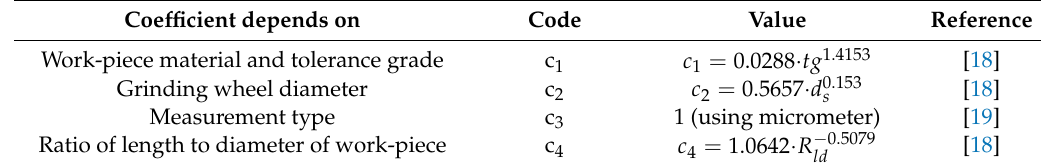
Table 1. Coefficients for determining the radial wheel feed.